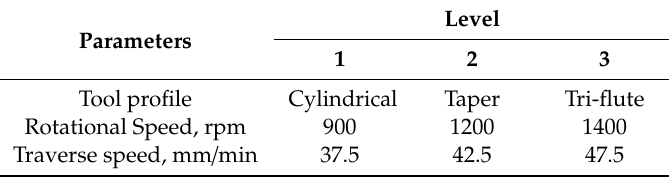
Table 7. Taguchi L 9 orthogonal array parameter setting and experimental results of hardness and tensile strength.